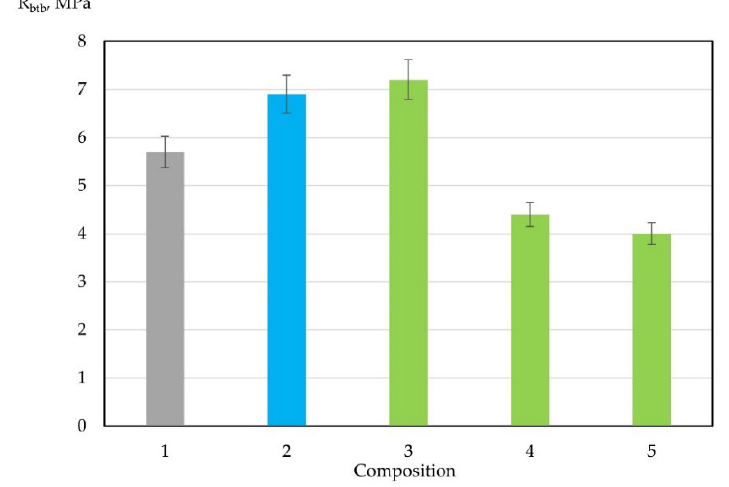
Figure 9. Change in tensile strength in bending of concrete samples at the age of 28 days: 1 (grey)—control composition; 2 (blue)—electromagnetically treated cement paste without RSA; 3, 4, 5 (green)—electromagnetic treated cement paste with RSA of different dosage according to Table 6.